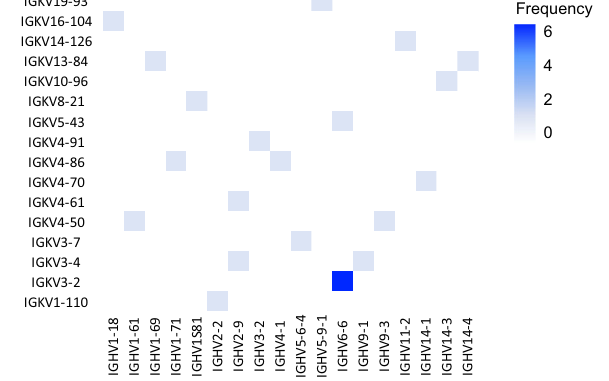
Fig. 5 Isolation of trimer-speci fi c monoclonal antibodies from an animal (272.8) with potent neutralization activity against BG505.T332N post vaccinations with DNA-encoded BG505.MD39. a Vaccination and tissue collection scheme for 272.8. b Trimer-speci fi c binding antibody responses in 272.8 2 weeks post the fi nal vaccination. c Autologous BG505.T332N neutralizing activity induced in 272.8 2 weeks post the fi nal vaccination. d Gating strategy used to isolate antigen-speci fi c CD19 + IgD − IgM − BG505.MD39-Tetramer-FITC + BG505.MD39-Tetramer-PE + B-cells from spleen and